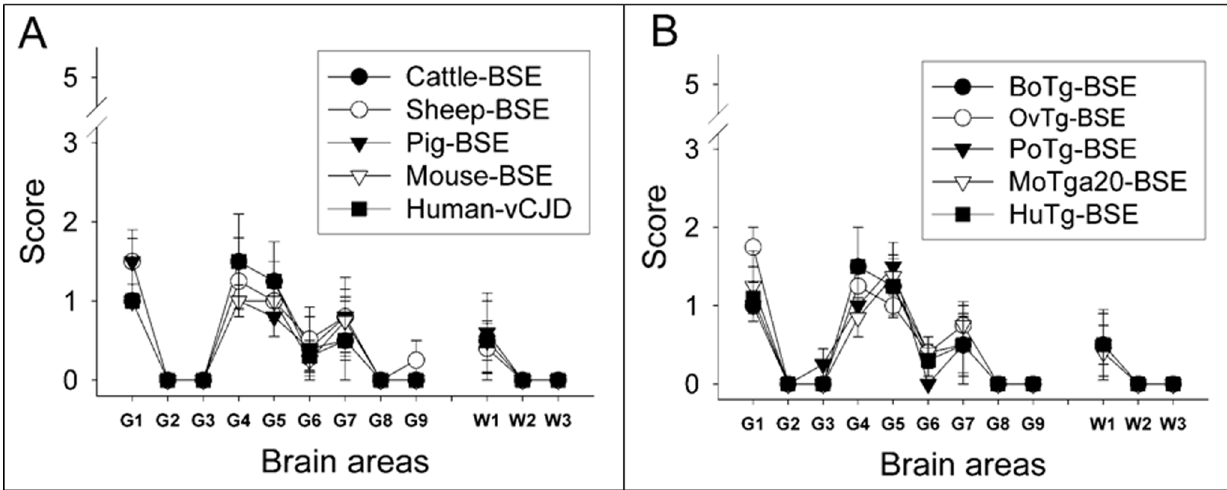
Figure 7. Lesion profile in the brain of BoPrP-Tg110 mice. A) Lesion profile in BoPrP-Tg110 mice infected (1 st passage) with the different BSE- derived prions propagated either in the natural hosts (A) or in transgenic mouse models expressing their corresponding PrP C sequence (B). Lesion scoring is determined for nine areas of grey matter (G) and white matter (W) in the mouse brains: dorsal medulla (G1), cerebellar cortex (G2), superior colliculus (G3), hypothalamus (G4) medial thalamus (G5), hippocampus (G6), septum (G7), medial cerebral cortex at the level of the thalamus (G8) and at the level of the septum (G9), cerebellum (W1), mesencephalic tegmentum (W2) and pyramidal tract (W3).